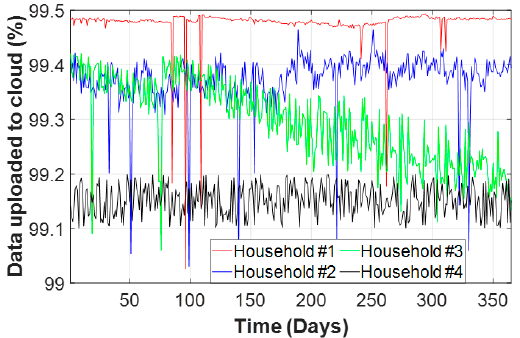
Figure 6. Percentage of successful data-to-cloud upload in